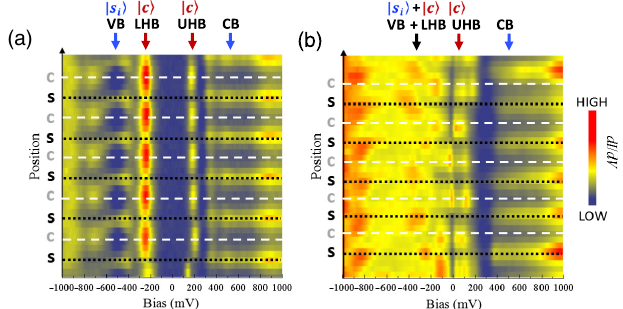
FIG. 5. STM line map. The dI=dV data for (a) x ¼ 0 and (b) x ¼ 1 in an extensive two-dimensional parameter space. The horizontal axis is the STM bias and the vertical axis is the position. The white dashed (black dot) lines mark the center (surrounding) of the